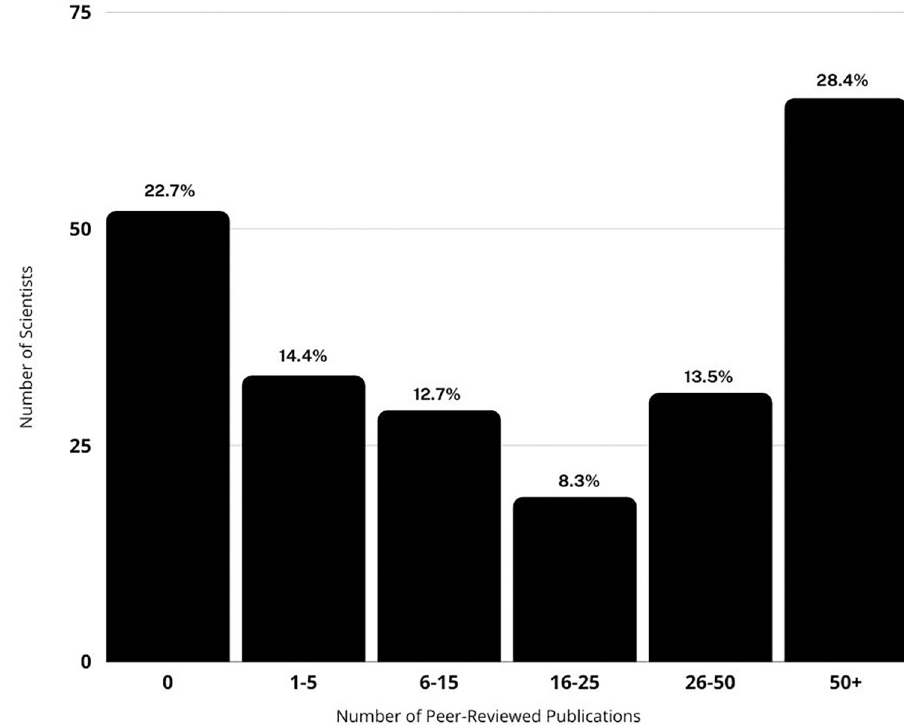
Fig 5. Frequency of number of scientific publications authored by Shark Week